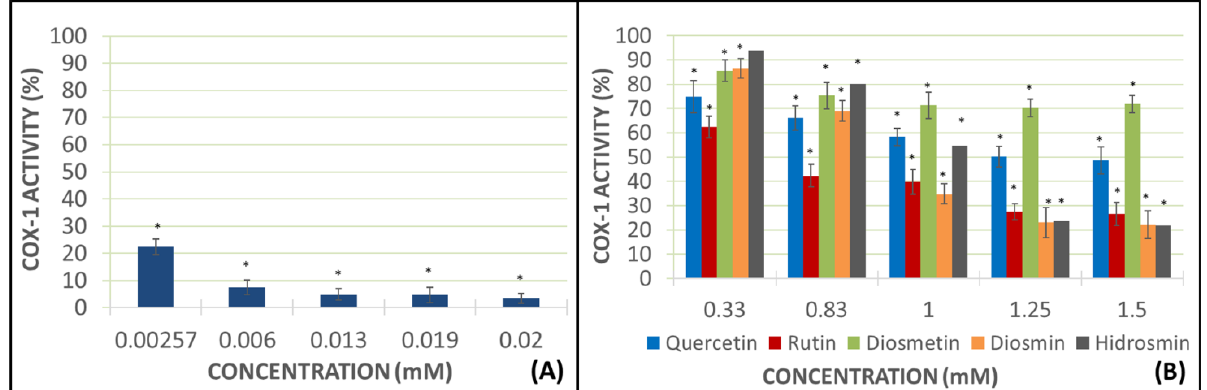
Figure 4. This diagram shows h-COX-1 works in presence of indomethacin as a positive control (panel ( A )) and with different concentrations of each flavonoid (panel ( B )). Error bars indicate the standard deviation. Color bars describe the mean and standard deviation for N = 8. * p < 0.05: significant variations of h-COX-1 in the presence or absence of the assayed compounds.